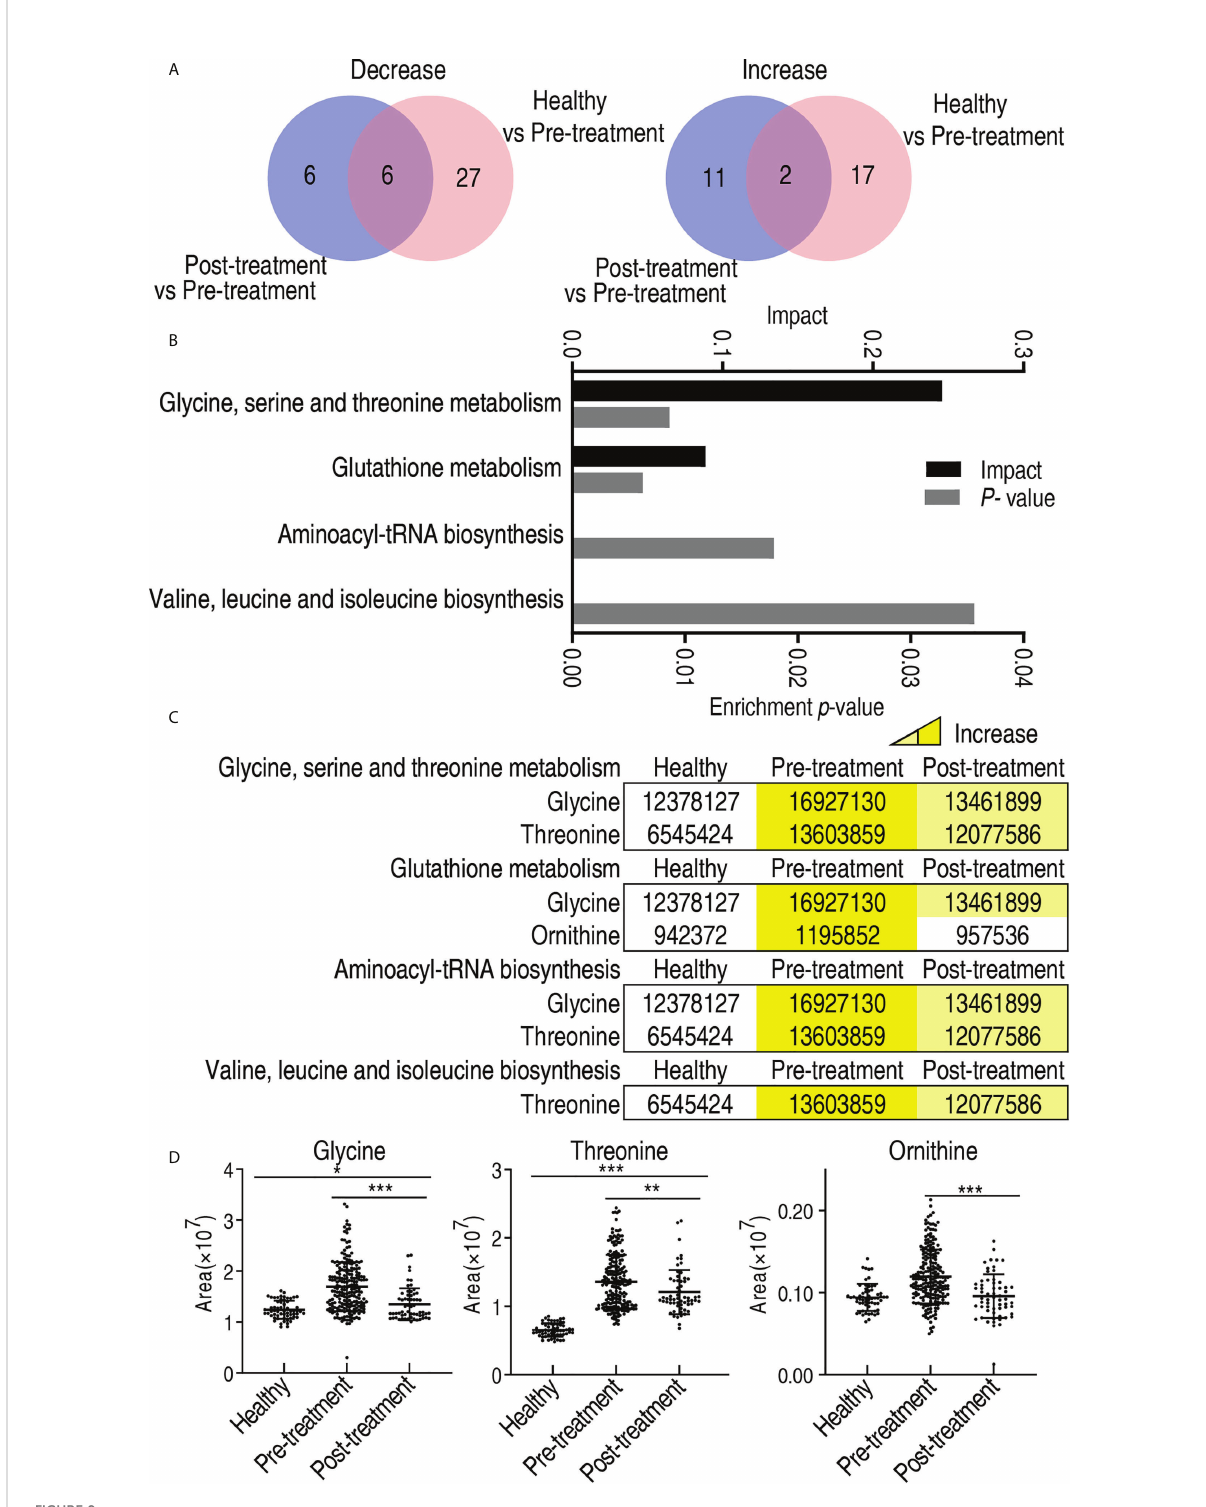
FIGURE 9 Differential metabolites and metabolic pathway enrichment between patients who received treatment and patients who did not receive treatment. (A) Venn diagram for overlapped and unique metabolites between healthy individuals/patients who did not receive treatment (pre- treatment) and patients who received treatment/patients who did not receive treatment (pre-treatment). (B) Pathway enrichment of differential abundant metabolites. (C) Abundance of the differential metabolites of pre-treated and post-treated esophageal cancer patients compared with healthy individuals. Yellow and blue indicate increase and decrease of metabolites, respectively. (D) Abundance of biomarkers. Results are displayed as mean ± SEM. * p < 0.05, ** p < 0.01, and *** p < 0.001 as determined by Student ’ s t